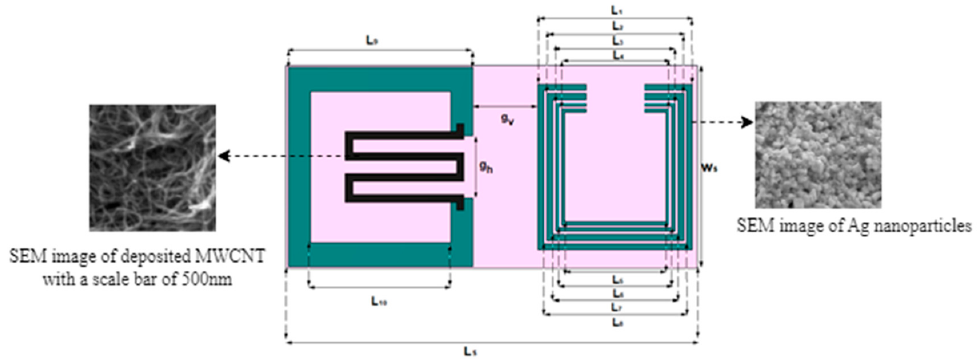
Figure 3. Proposed Tag Dimension and SEM Image of MWCNT. Table 1. Optimized tag dimensions.